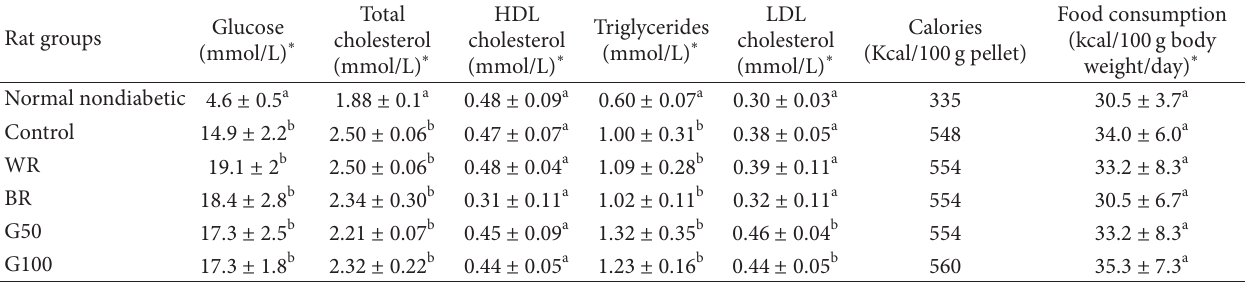
T 3: Baseline parameters for the rat groups aer the induction of diabetes and the level of food consumption of each group. Rat groups